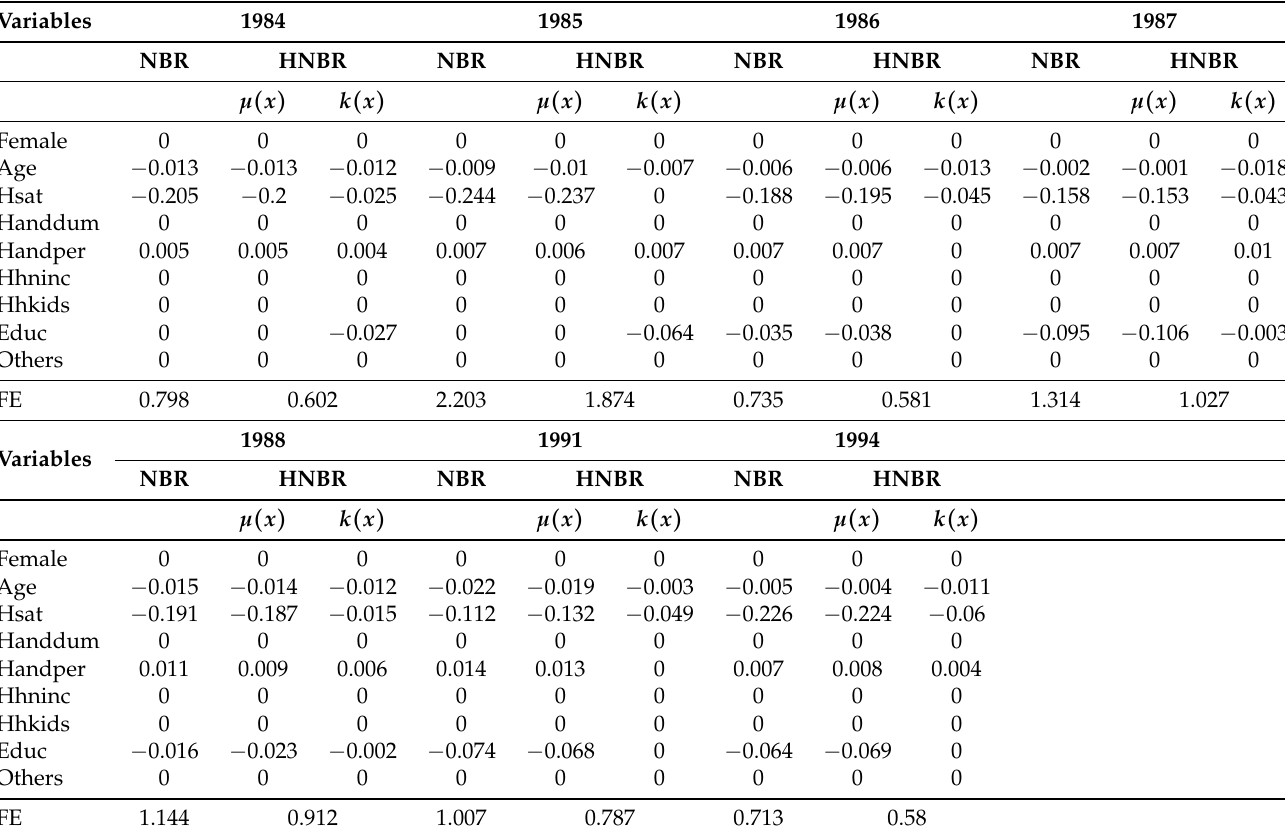
Table 3. The variable selection results and the fitting errors (FE) of NBR and HNBR models. The variable Others = { Married, Haupts, Reals, Fachhs, Abitur, Univ, Working, Bluec, Whitec, Self, Beamt, Public, Addon } . Because these variables are not selected in any year, we put them in “Others” for